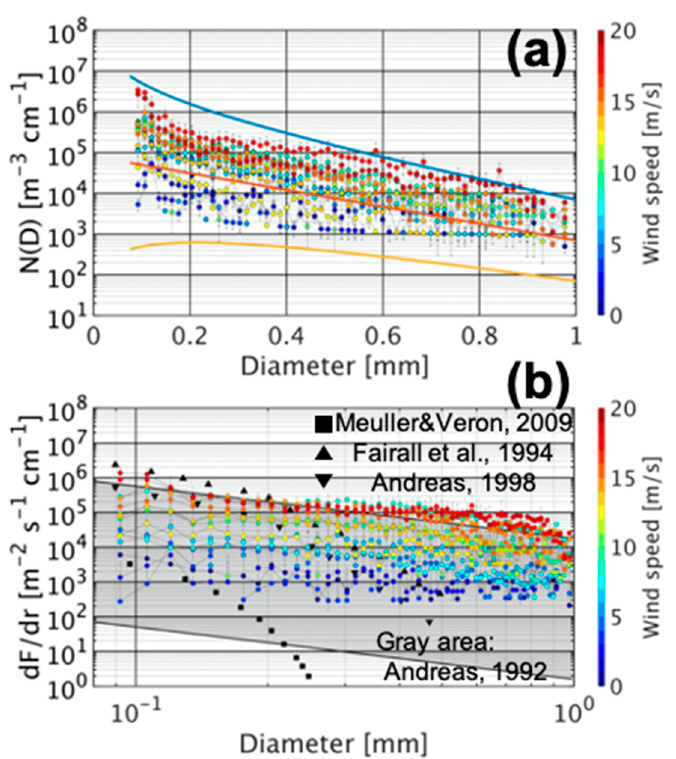
Figure 6. DSDs that may include droplets derived from both rainfall and sea spray. Each DSD is averaged for each hourly wind speed. The black bars show standard deviation ( σ ). Bar colors indicate hourly wind speed. ( a ) Ulbrich distribution for different values of μ , where light blue = − 1, red = 0, and orange = 1. ( b ) DSDs of sea spray at hourly wind speeds ranging from 1 to 20 m s − 1 in intervals of 1 m s − 1 . The DSDs calculated in previous studies are also shown [33,35–37].